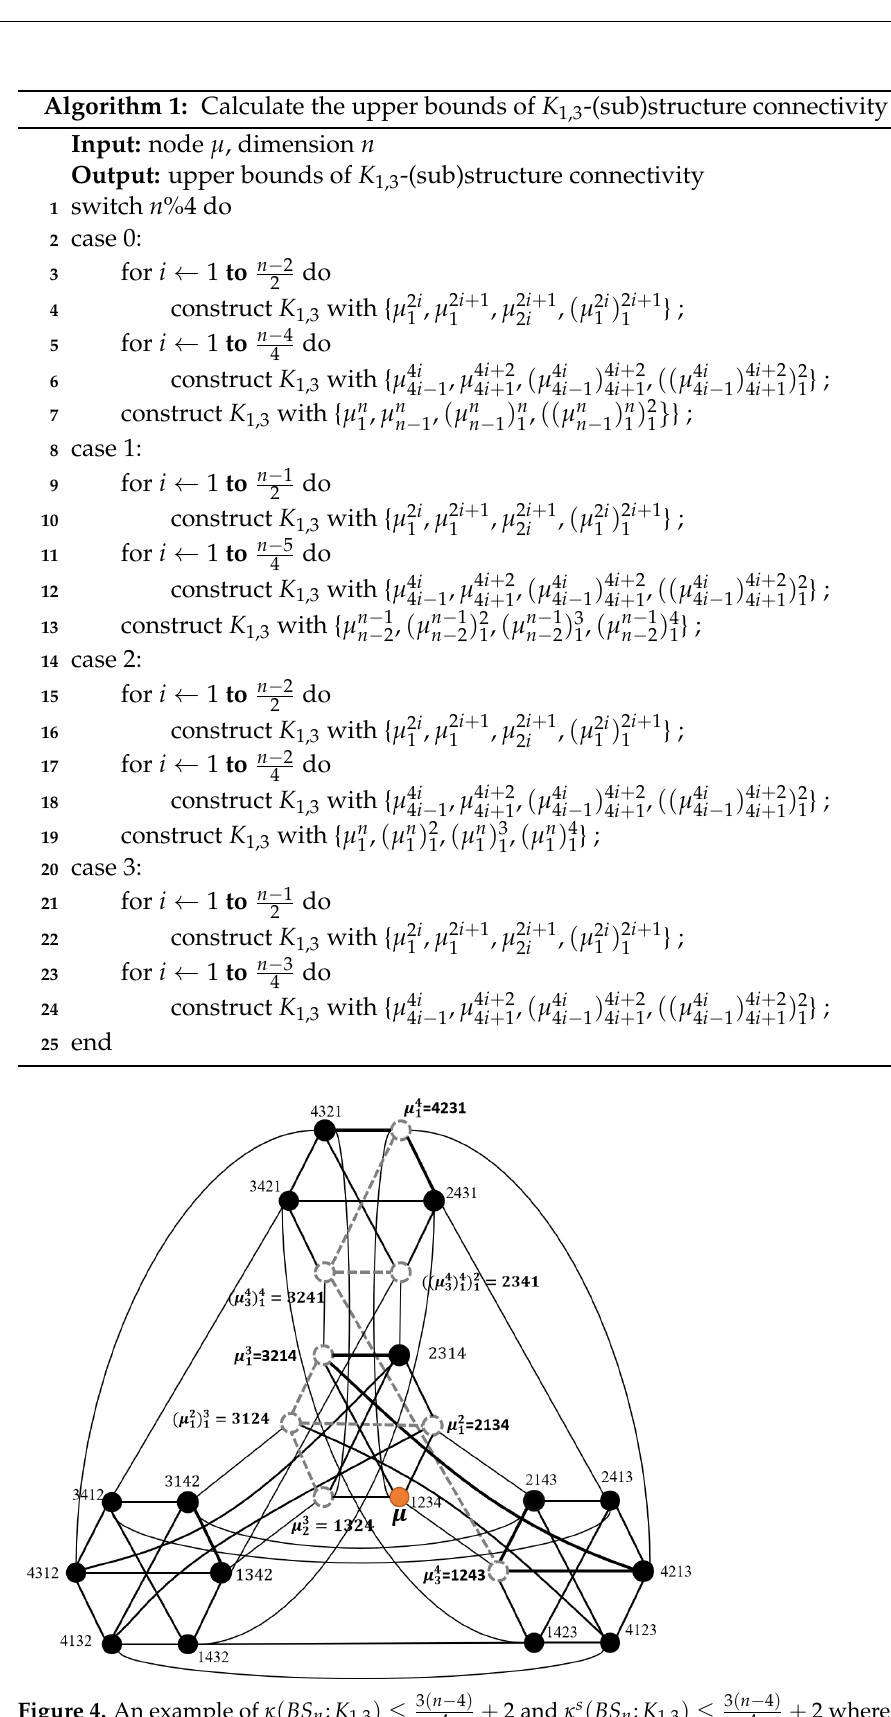
Figure 4. An example of κ ( BS n ; K 1,3 ) ≤ 3 ( n − 4 )